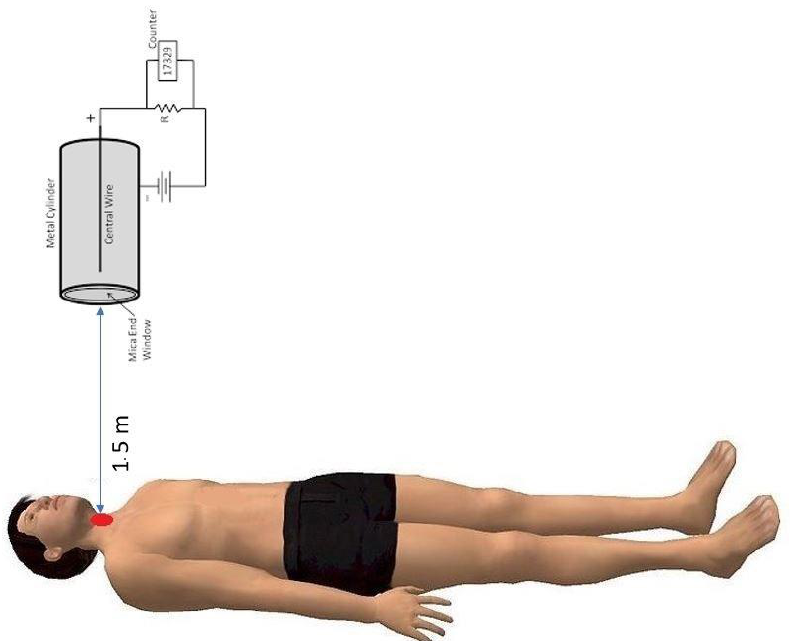
Figure 1. An illustration of the monitoring system used for this study. Data have been measured with a Geiger–Muller counter fixed on the ceiling of each protected room, at approximately 1.5 m above the patient’s head.